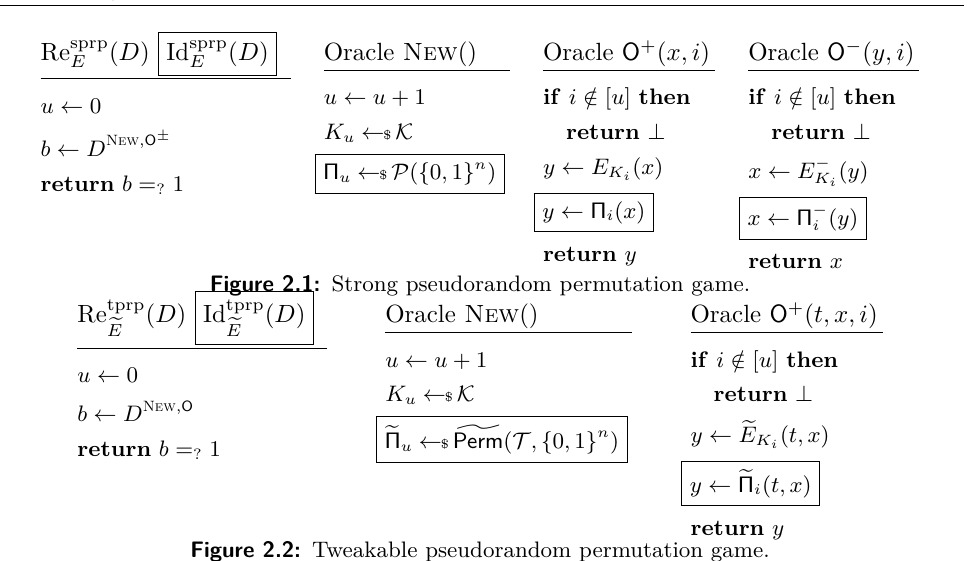
Figure 2.2: Tweakable pseudorandom permutation game.